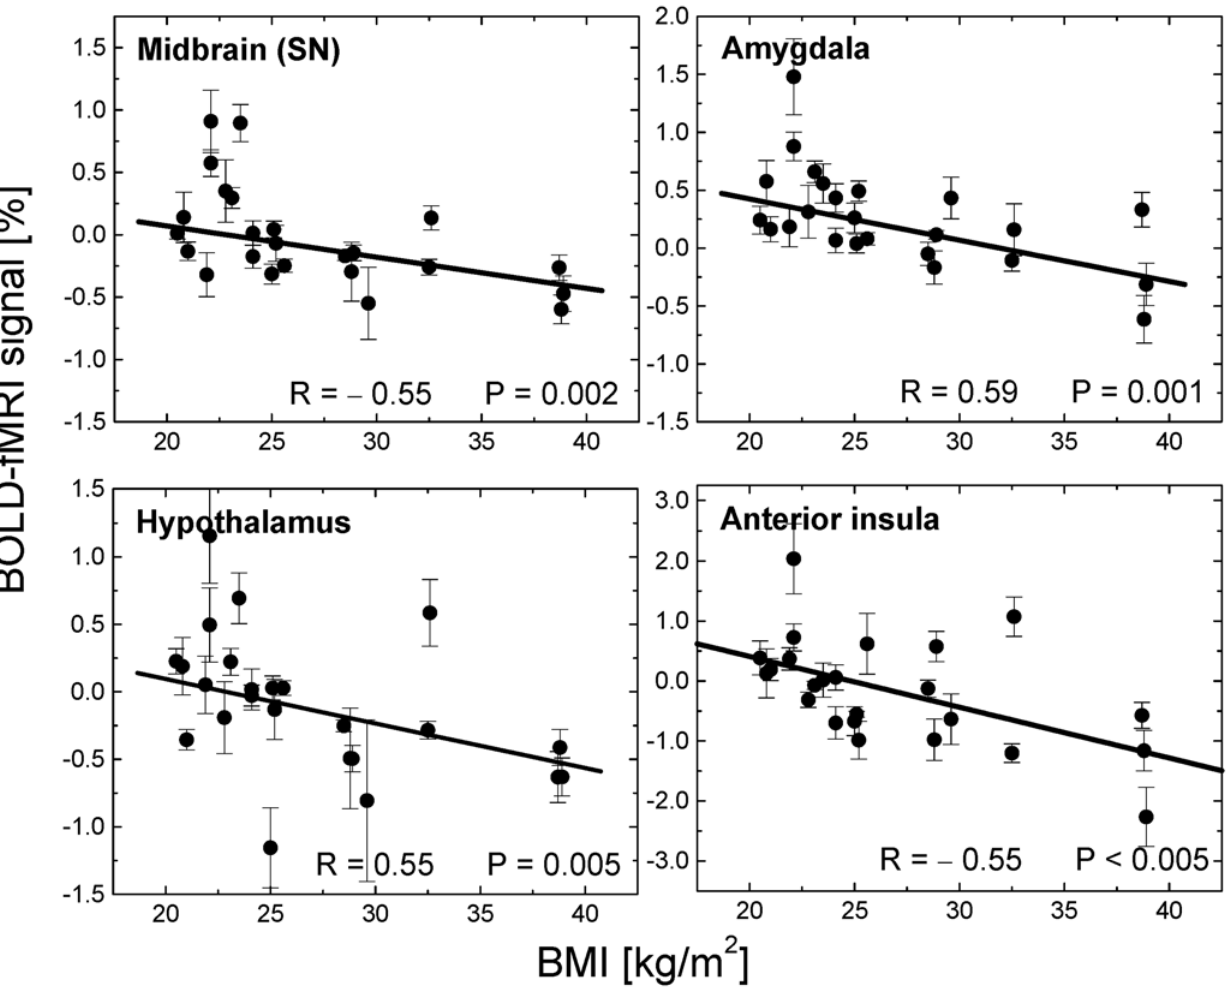
Figure 5. BOLD signals in hypo-activated regions vs. BMI. Scatter plots exemplifying the negative correlations between BMI and the average BOLD-fMRI responses across all volumetric conditions (125, 375, 500, 600, and 700 ml) in dopaminergic brain regions (hypothalamus, midbrain, and amygdala) during gradual GD (N=24).